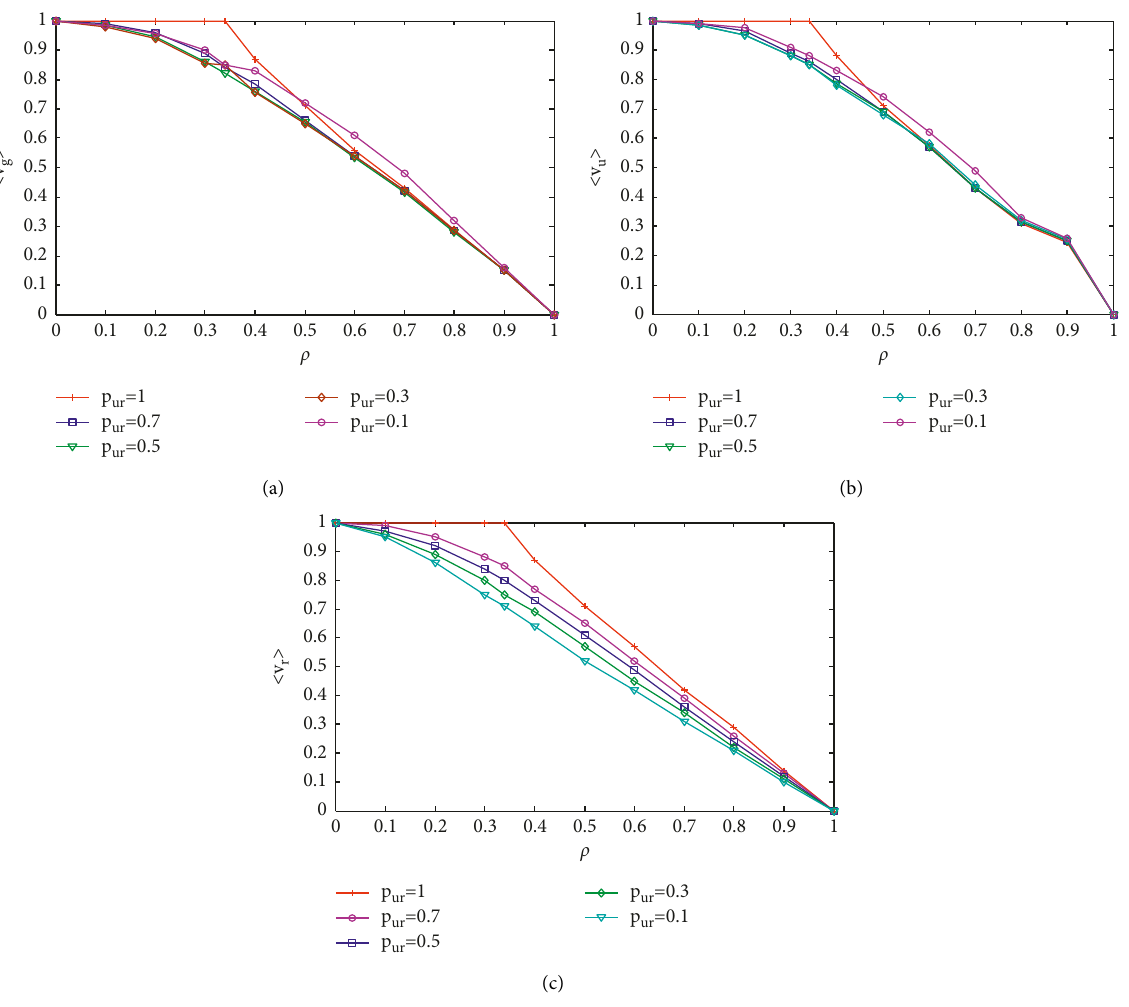
ur and (b) the relationship